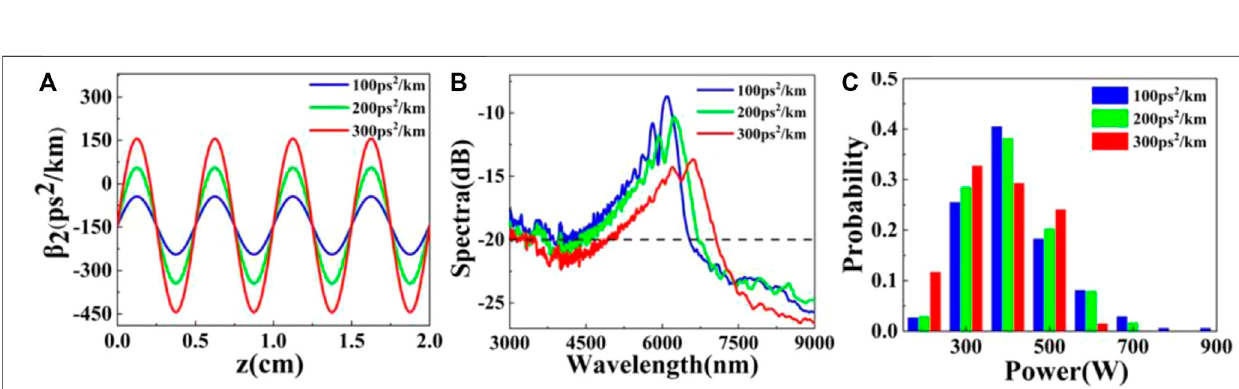
Frontiers in Physics |